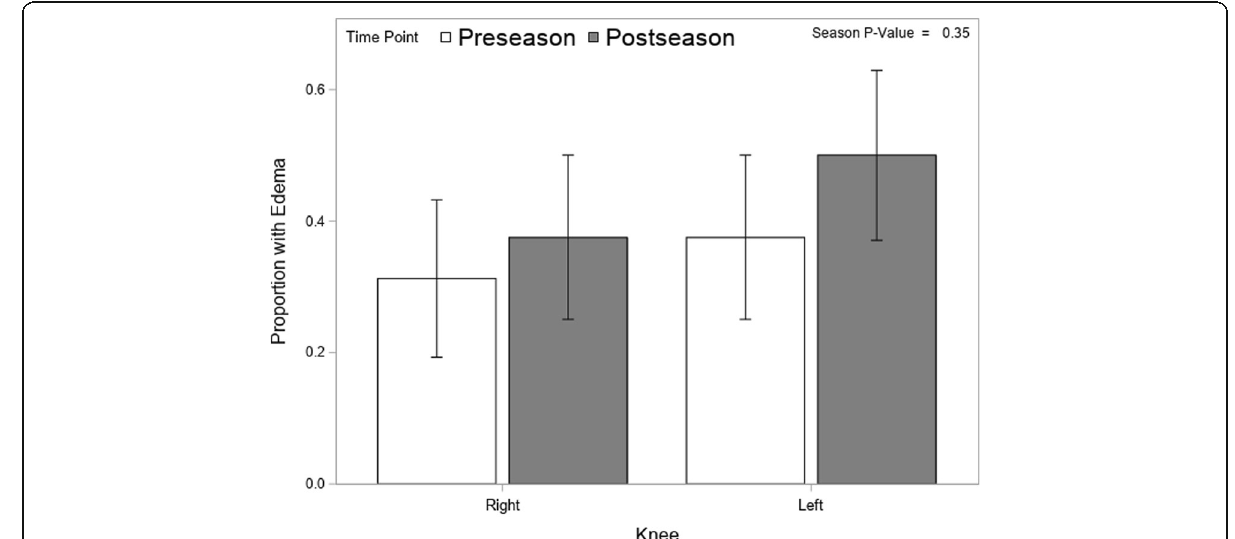
Fig. 3 Proportion (± SE) of Athletes Displaying Edema by Knee and